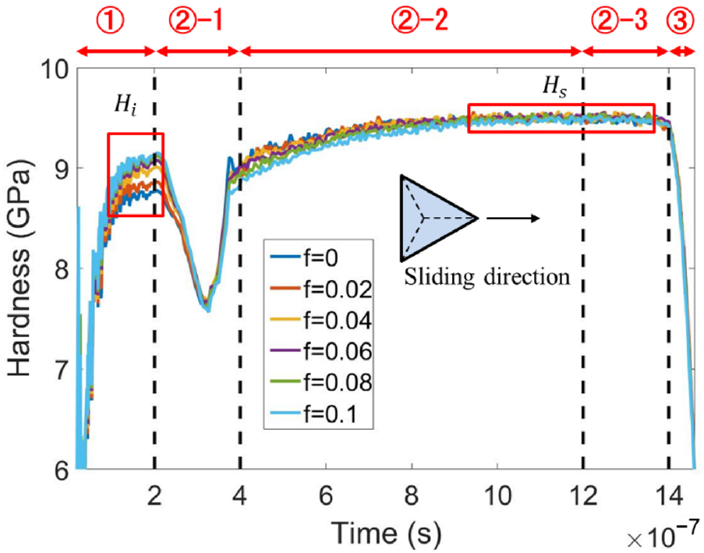
Figure 9. The variation of hardness with time at various values of adhesion friction coefficient f for `edge-leading Berkovich scratching.